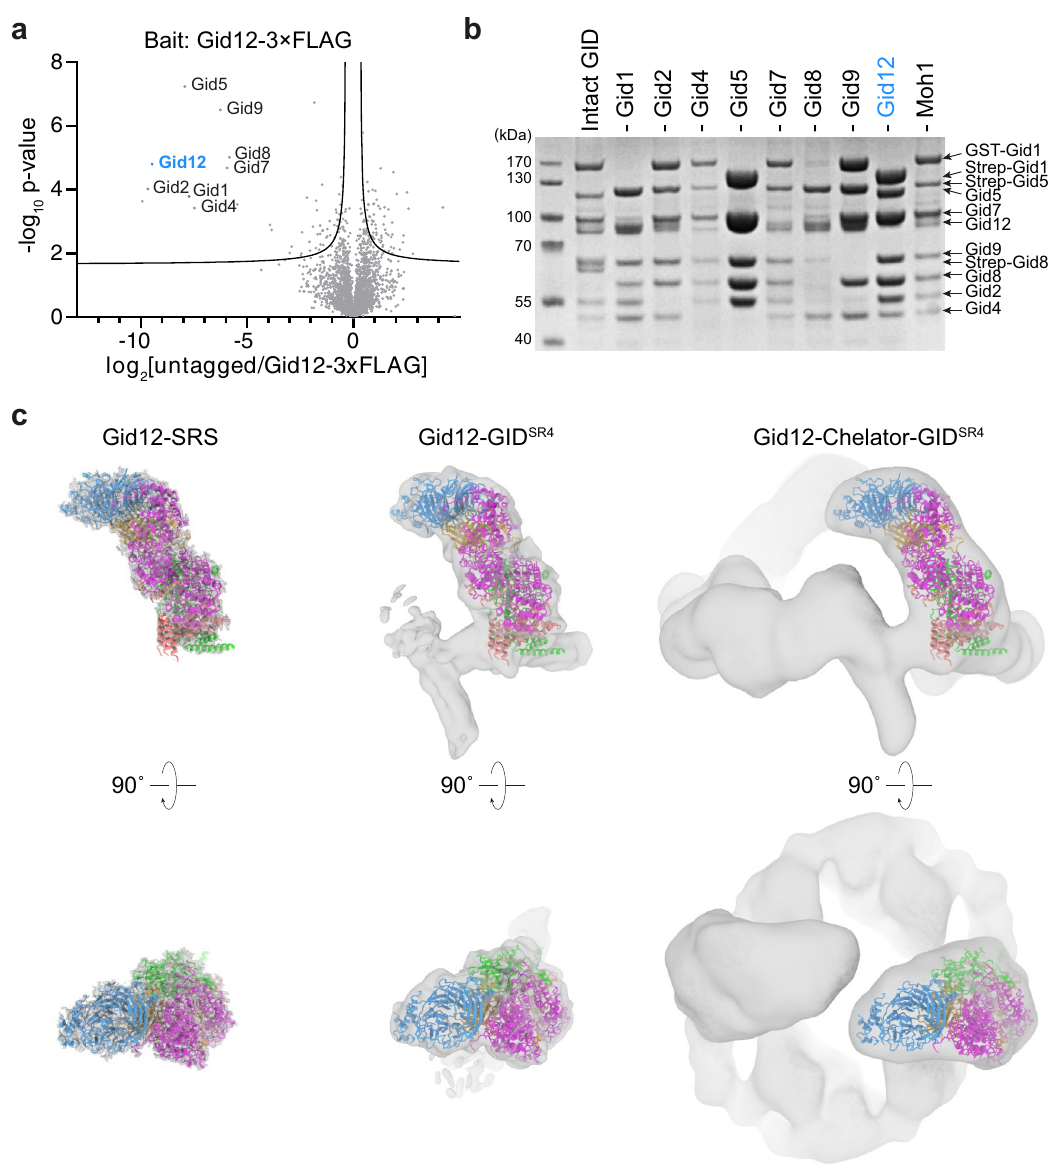
Fig. 1 Gid12 binds to the Gid4-containing GID E3 ligase complexes. a Quantitative MS identi fi cation of proteins interacting with Ipf1-3×FLAG (originally YDL176W, now called Gid12) or an untagged control strain under glycolytic conditions ( n = 3 biologically independent samples). Data are log-transformed ratios of protein LFQ intensities versus − log10-transformed P values of two-tailed Student ’ s t tests. The hyperbolic curve separates speci fi cally interacting proteins from background (square; false-discovery-rate-adjusted P = 0.05; minimal fold change S0 = 0.1). The bait protein Gid12 is highlighted in blue. b SDS-PAGE of GST- or Strep-af fi nity puri fi cations after co-infecting insect cells with all GID E3 ligase subunits except the one indicated above the lane. Lane 1 shows the result from a control co-infection with all subunits ( n = 3 biologically independent experiments). c Coordinates of Gid12 bound to the substrate-receptor and scaffolding module (Gid12-SRS) were docked into the cryo-EM density maps of Gid12-SRS, Gid12 bound to GID SR4 (Gid12-GID SR4 ) and Chelator-GID SR4 (Gid12-Chelator-GID SR4 ) at 3.3, 9.8, and 19.4 Å resolution, respectively, from left to right. Gid12 is colored in blue, Gid4 in gold, Gid5 in magenta, Gid8 in salmon, and Gid1 in